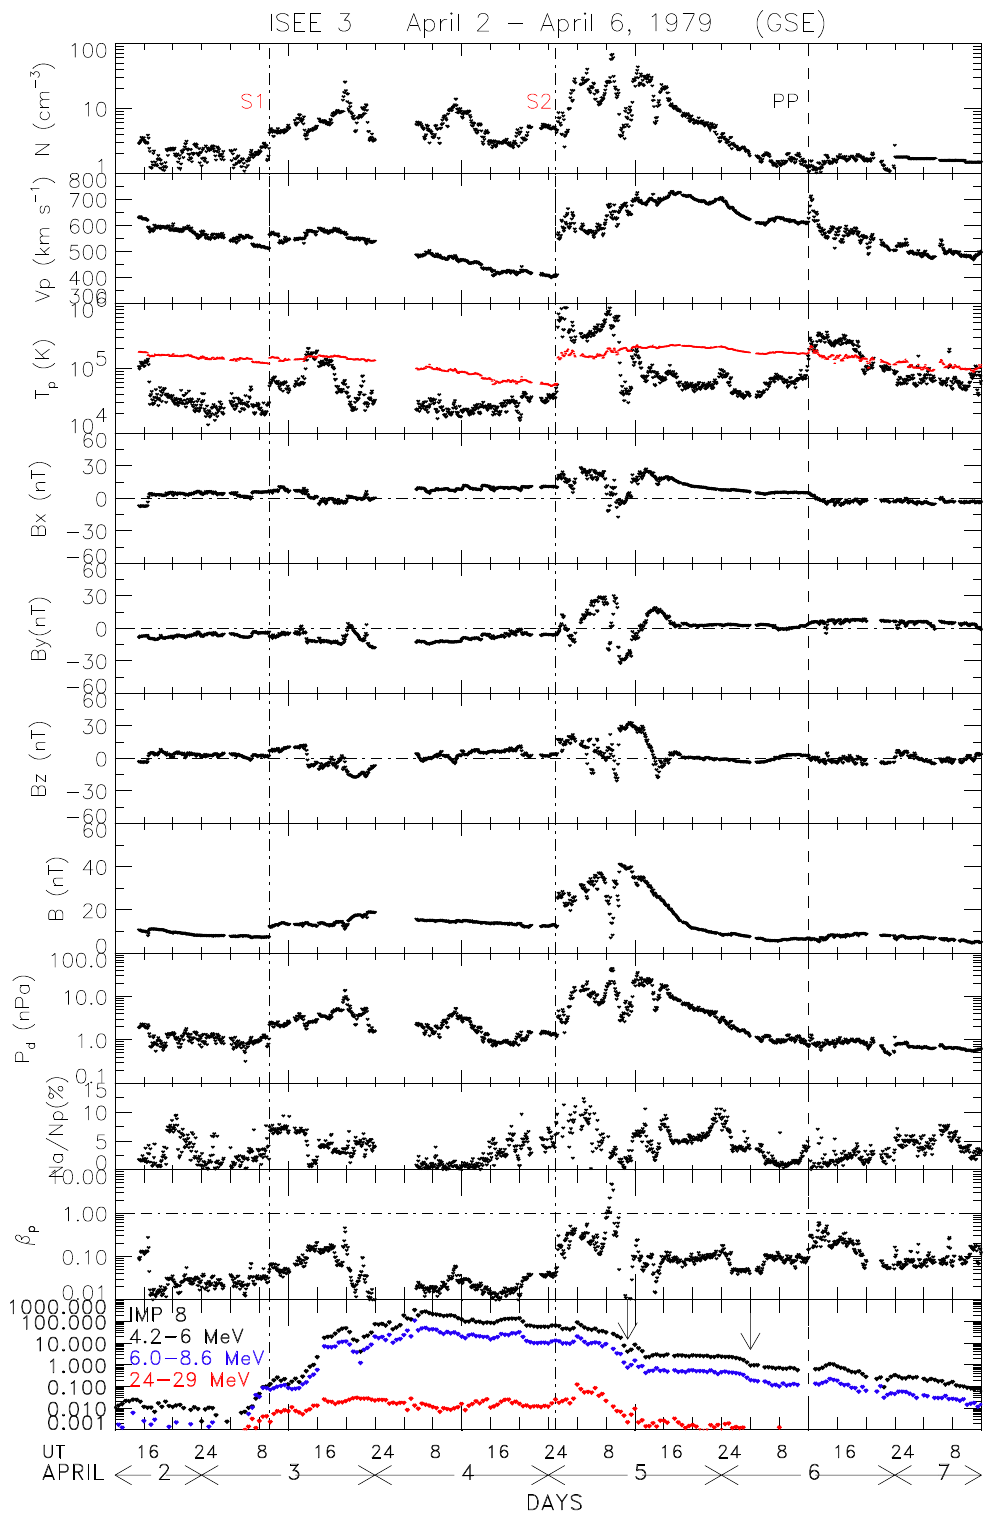
Fig. 3. Data acquired by ISEE-3 at 1AU, presented in the same format as Fig. 2. Note that the time axis is advanced by 12h relative to that in Fig.